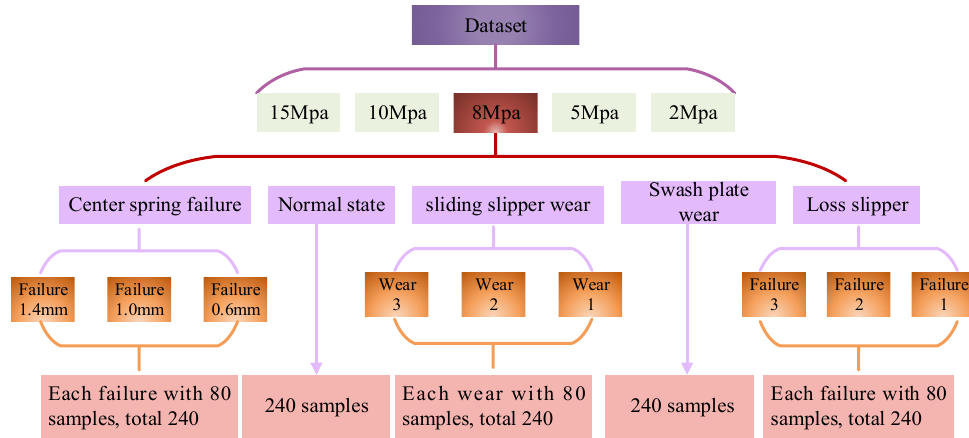
Figure 5. The composition of the sample set when the working pressure is 8 MPa.